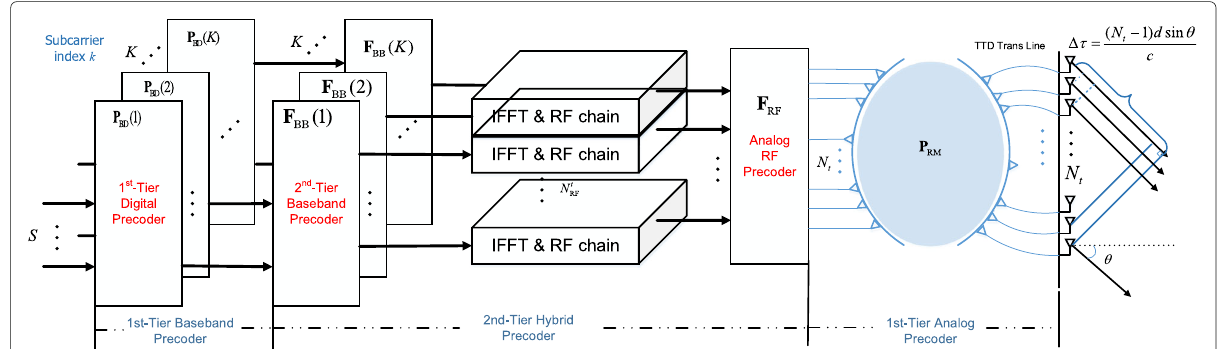
Fig. 3 The two-tier hybrid beamforming for multiuser mmWave MIMO-OFDM